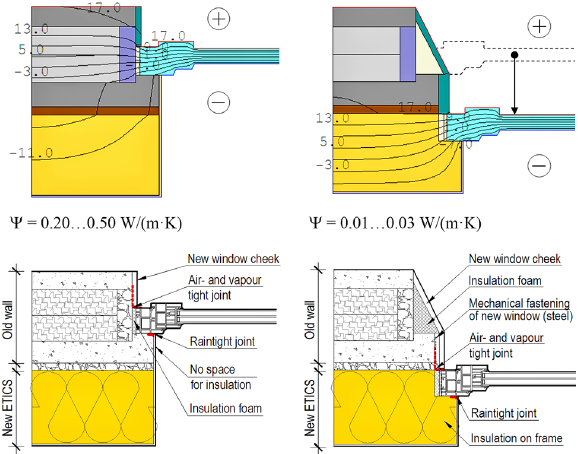
Fig. 8. Examples of bad practice (left) and best practice – windows are repositioned into additional insulation (right). Isotherms in both cases are presented in upper row and designed principal renovation solution in bottom